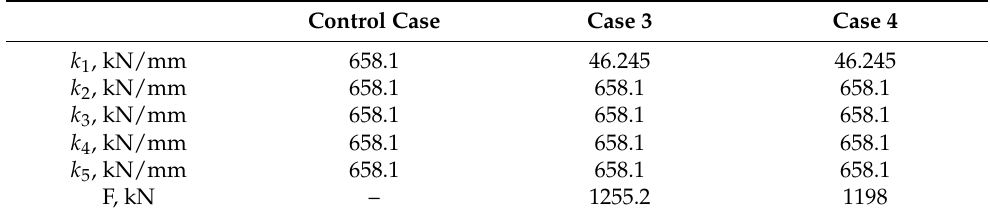
Table 6. Stiffness and friction values used in the dynamic models of the control case, Case 3 and Case